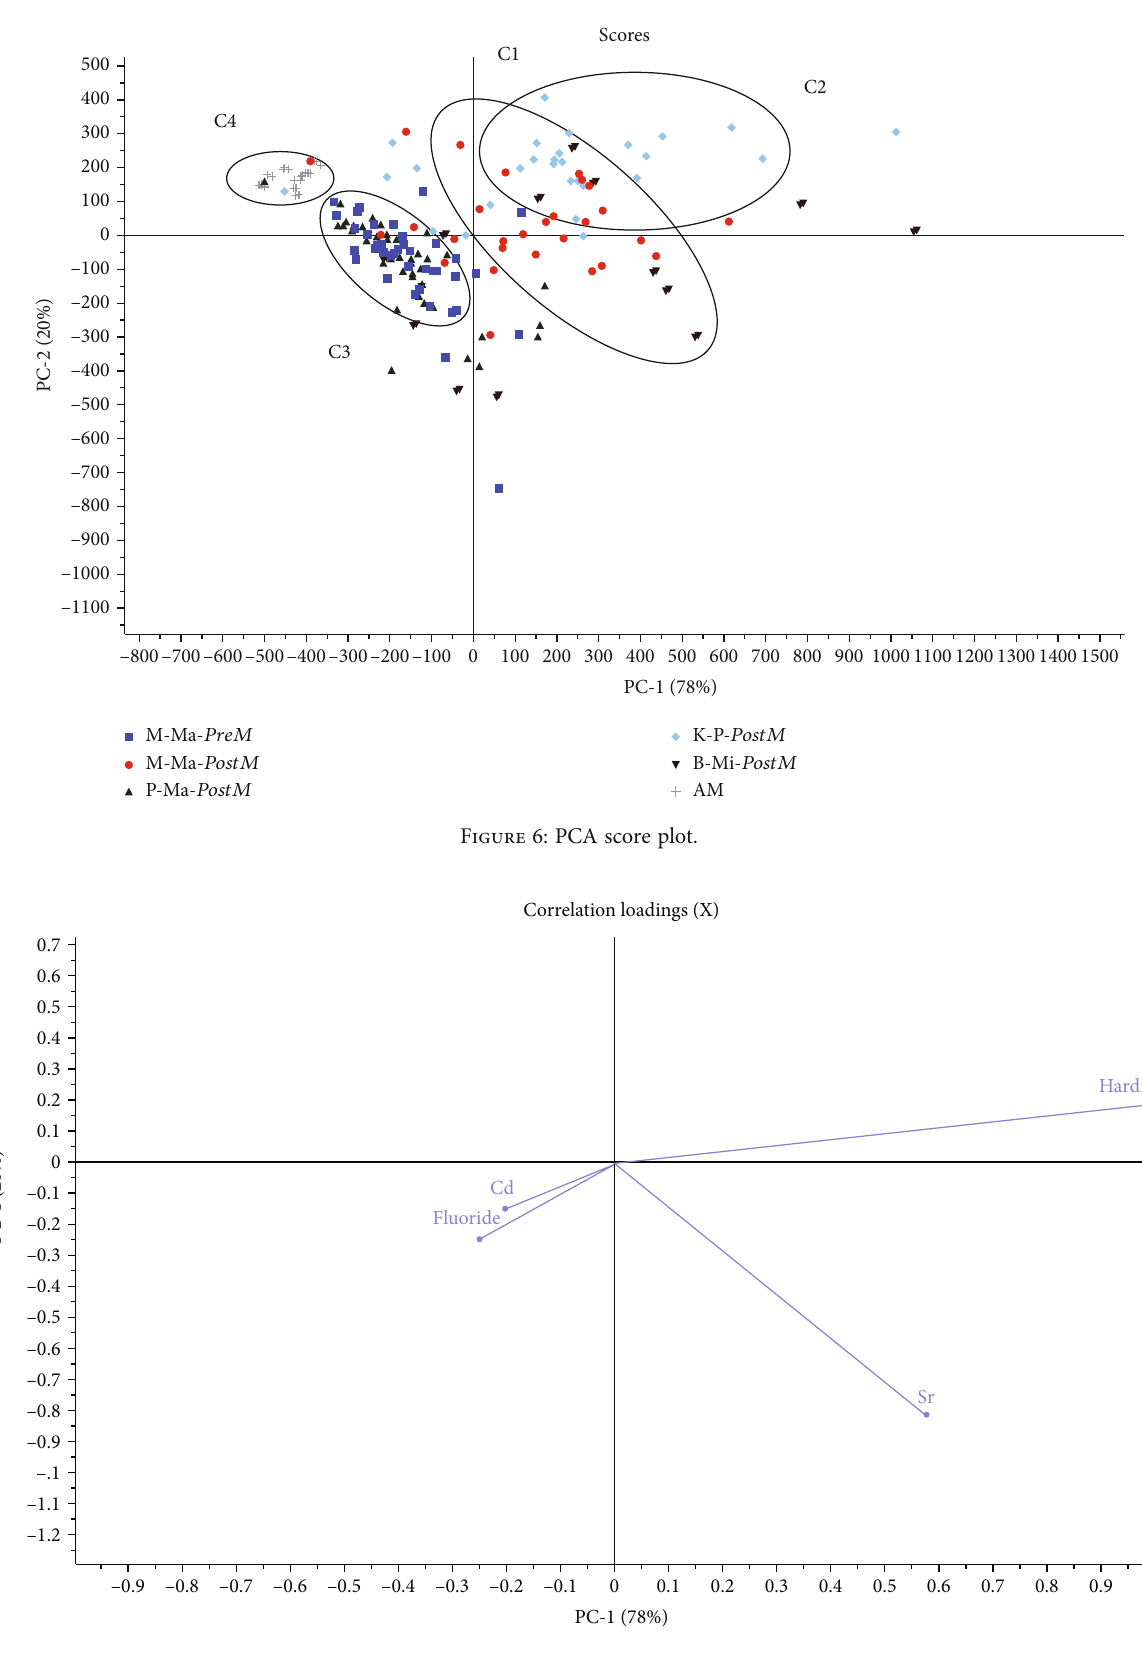
Figure 7: PCA loading